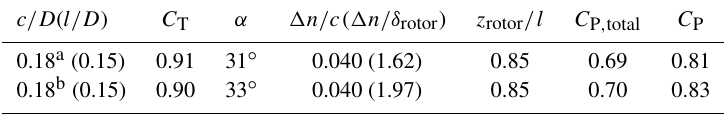
Table 2. The Reynolds number sensitivity of optimal design for C P , total . c/D ( l/D